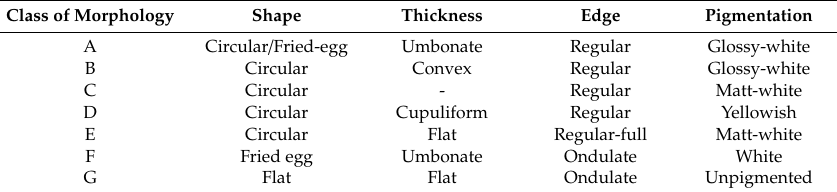
Table 4. Morphological descriptions of the 35 bacterial isolates obtained from the composts (P1–11).